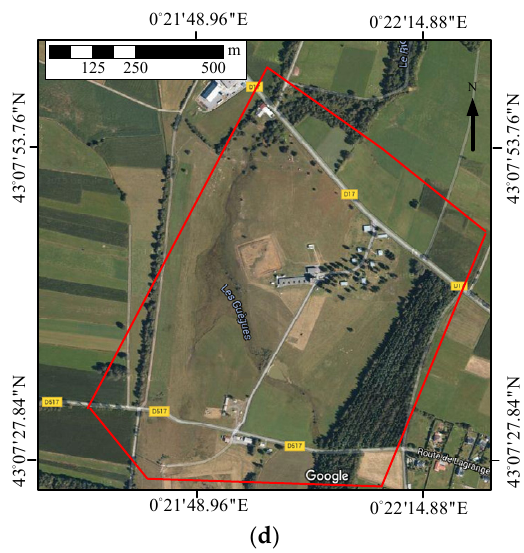
Figure 3. Overview imagery of the three test sites: ( a ) Dataset 1 (BaiduMap [27]); ( b ) Dataset 2 (GoogleMap [28]); ( c ) Dataset 3 (GoogleMap [28]); and ( d ) Dataset 4 (GoogleMap [28]).